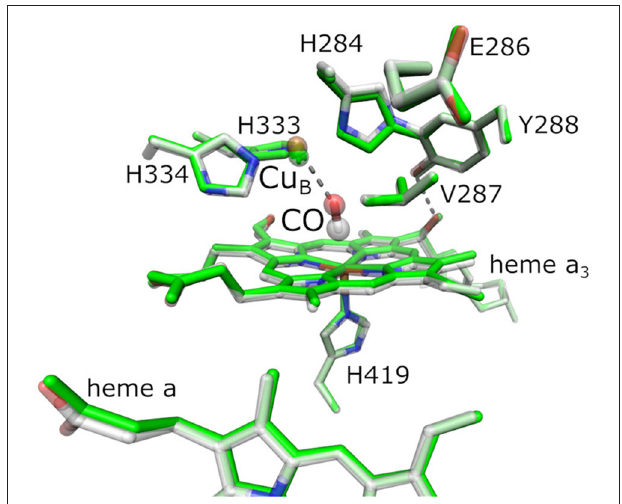
FIGURE 1 | Active site of bovine cytochrome c oxidase ( Bt C c O) in the oxidized state (2DYR, in green) and in the fully reduced, CO-inhibited state (3AG1, with colored atoms). The binuclear center (BNC) comprehends heme a 3 , the copper ion Cu B , and a number of conserved residues as labeled. The highlighted residues H334, H333, H284, E286, Y288, V287, and H419 are labeled according to the Rs C c O nomenclature and are analogous to the actual residues H291, H290, H240, E242, Y244, V241, and H376 in Bt C c O shown